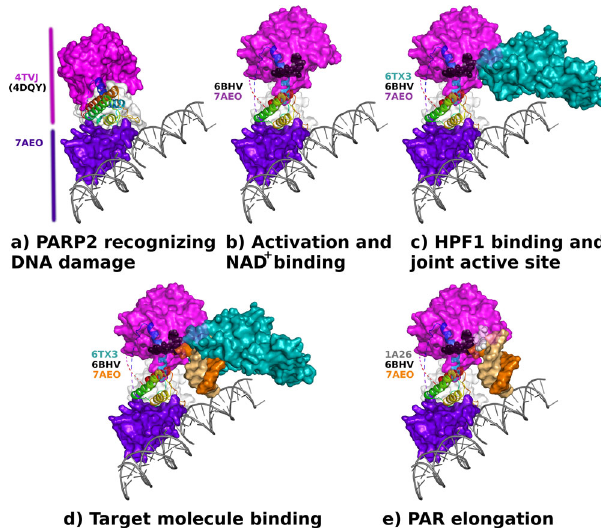
Fig. 6 Conformational changes upon PARP2 activation and substrate protein modi fi cation. a Inactive conformation of PARP2 when bound to DNA. b PARP2 undergoes a conformational change in the regulatory domain α -helices allowing NAD + (black) binding. c HPF1 can bind to the PARP2 catalytic domain to form a joint active site. d Conformational changes in the regulatory domain release the catalytic domain and allow it to modify target macromolecules marked here by the second DNA molecule observed in the crystal structure. e PARP2 can catalyse the PAR chain elongation reaction also without HPF1, which may dissociate from the complex. Carba-NAD + bound to the acceptor site is shown in white. PDB codes used for the illustrations are indicated in the